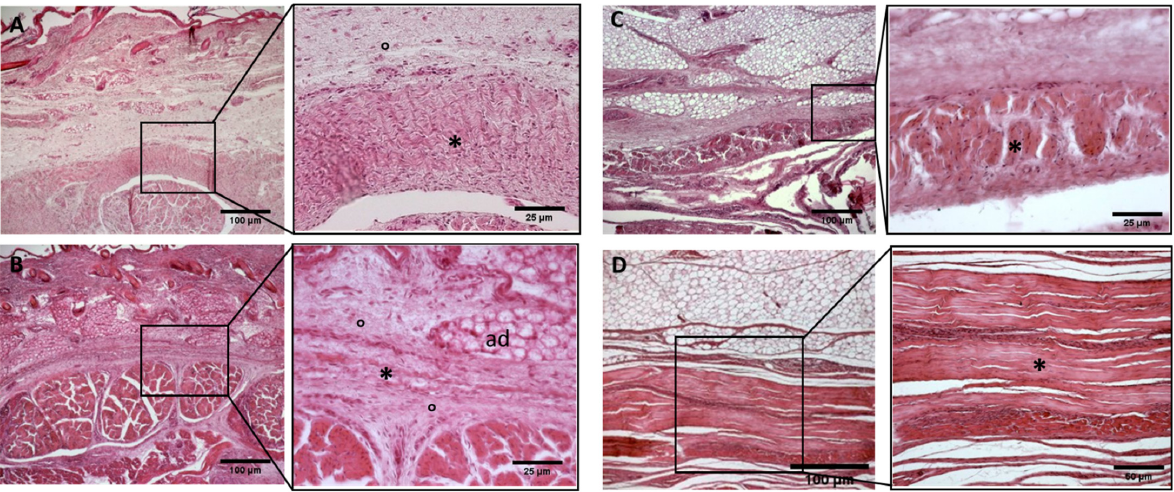
Figure 7. Histological images (hematoxilyn-eosin) of upper limb: extensor retinaculum develop- ment . ( A ): 24 weeks; ( B ): 27 weeks; ( C ): 38 weeks; ( D ): 40 weeks. (*): deep fascia; (°): mesenchymal cells; (mu): muscle; (ad): adipose tissue. The first part of gestation is distinguished ( A , B ) by an irregular connective tissue, whilst the second part of the gestation ( C , D ) showed up with a denser connective tissue, which was better organized in the fascial layers.